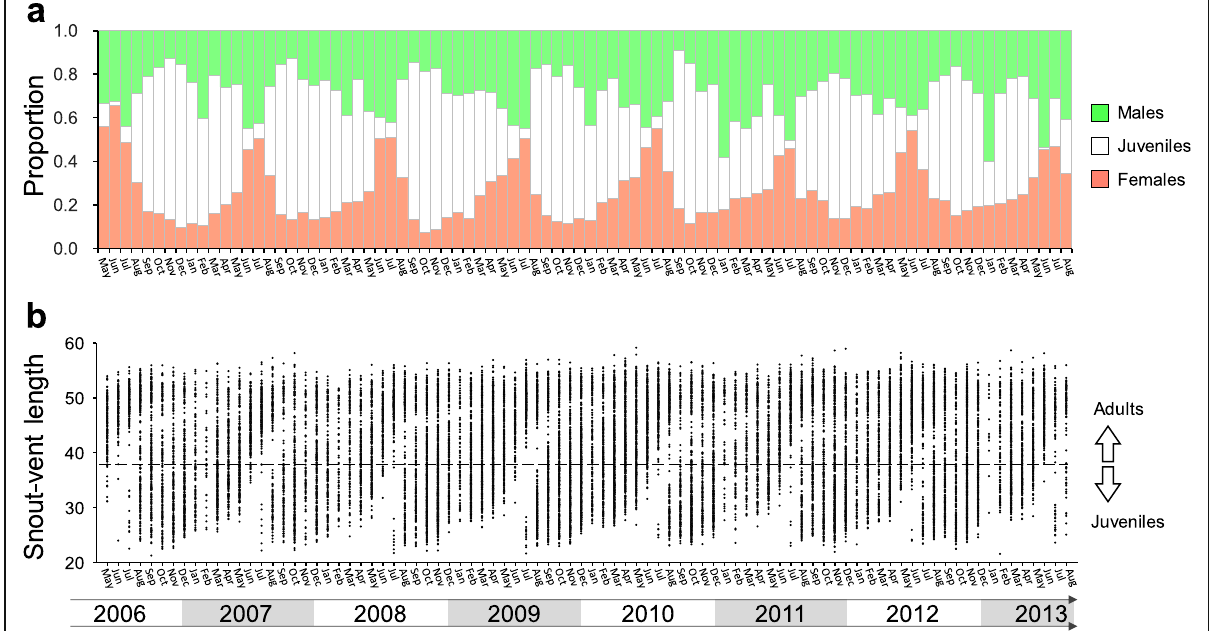
Fig. 3 The annual penetration cycles from juveniles to adults based on the eight-year capture data during 2006 – 2013. a Usually in August of every year, a notable amount of neonates begins to hatch, and reaches the highest proportion of the population from September to December. In the next spring, juveniles gradually reach the size of the adults and join the breeding group. After the breeding season, most adults die out and the cycle repeats. b The distribution of snout-vent length in each month demonstrates the annual cycle and the rapid growth from small- sized neonates and juveniles to large-sized